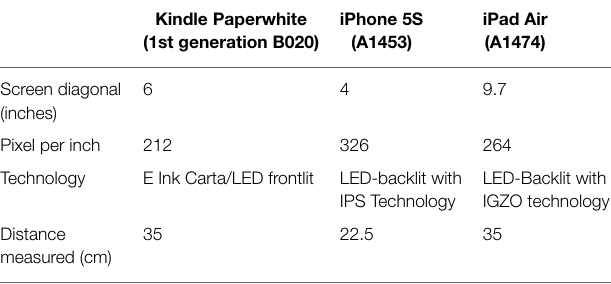
TABLE 1 | Physical properties of LE devices tested